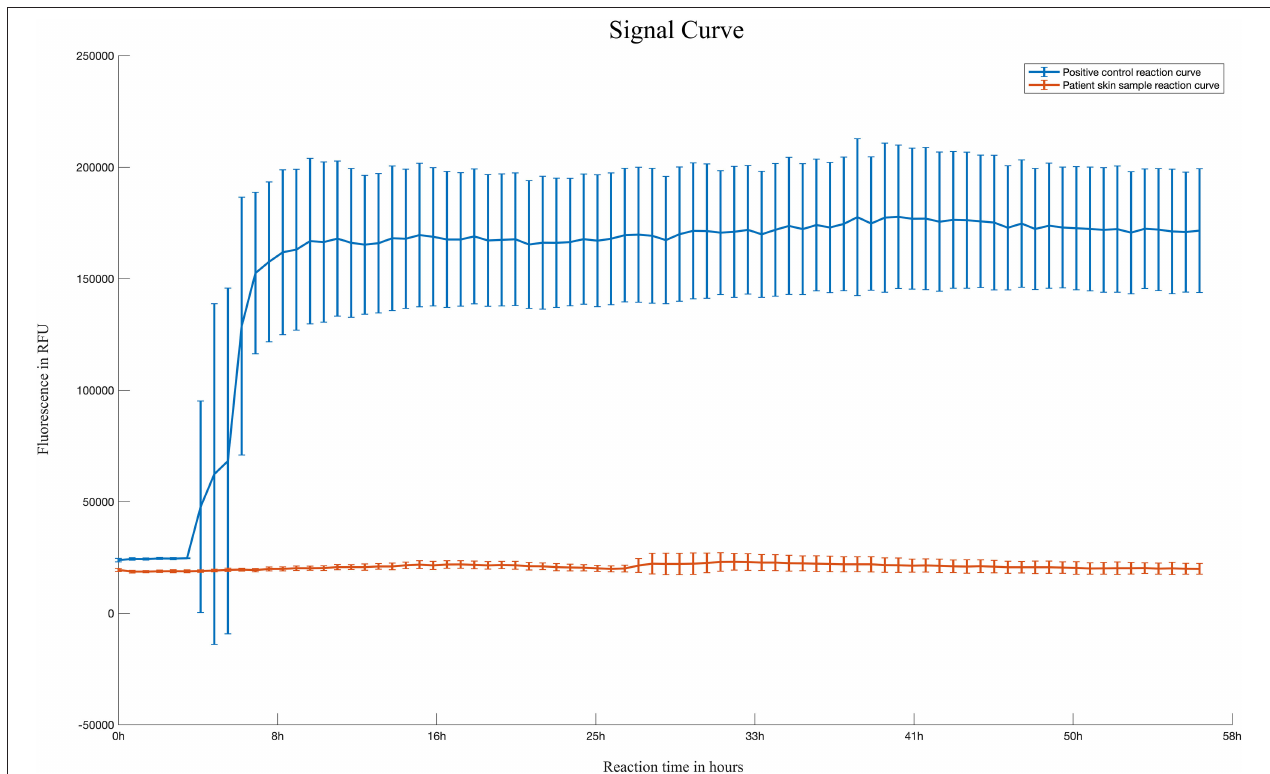
FIGURE 2 | Reaction curve of skin RT-QuIC of the patient. Reaction curves of skin RT-QuIC of the patient. Four replicate reactions of patient skin samples and four replicate reactions of the positive control (hamster scrapie 263K strain brain smear with a 10 − 7 dilution) were used in the RT-QuIC. Each line represents the reaction curve of positive control and patient sample, respectively. The means with standard deviations of those averages are shown as a function of RT-QuIC reaction time. The reaction curve did not show the peak of fluorescence in the patient sample (bottom), indicating a negative result of RT-QuIC. X-axis, hours post-reaction; Y-axis, fluorescence